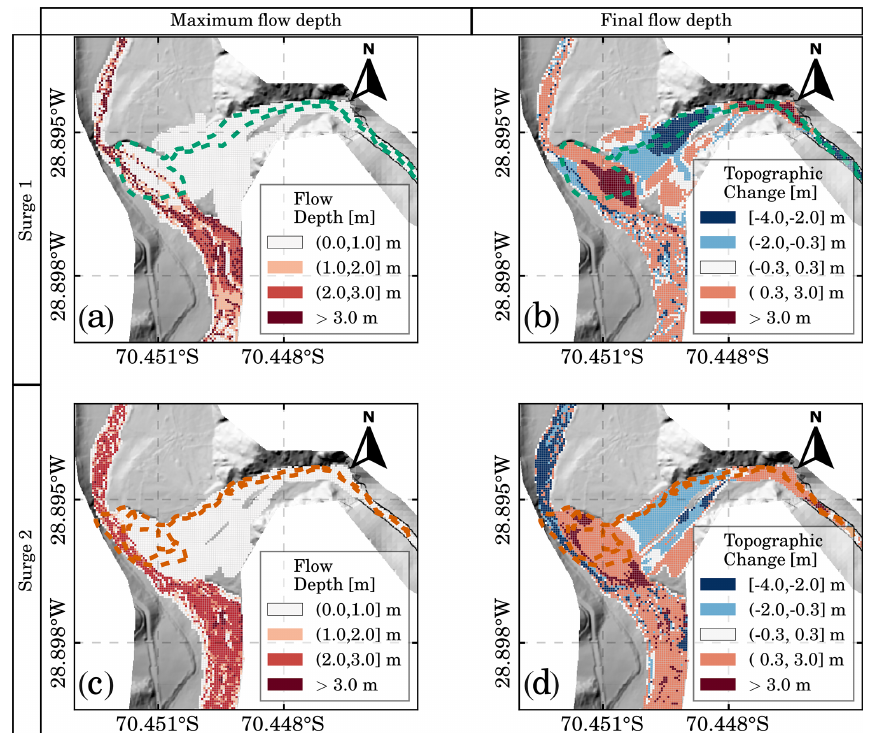
Figure 6. Inertial debris flow surges. Panels (a, b) correspond to the results for surge 3, whereas panels (c, d) correspond to the results for surge 4. Dashed polygons delimit the telescopic-like deposit, i.e., the incision in the alluvial fan and the new lobe at the fan toe. Pan- els (a, c) present the maximum flow depth, while panels (b, d) present the topographic change for erosion (negative values) and deposition (positive